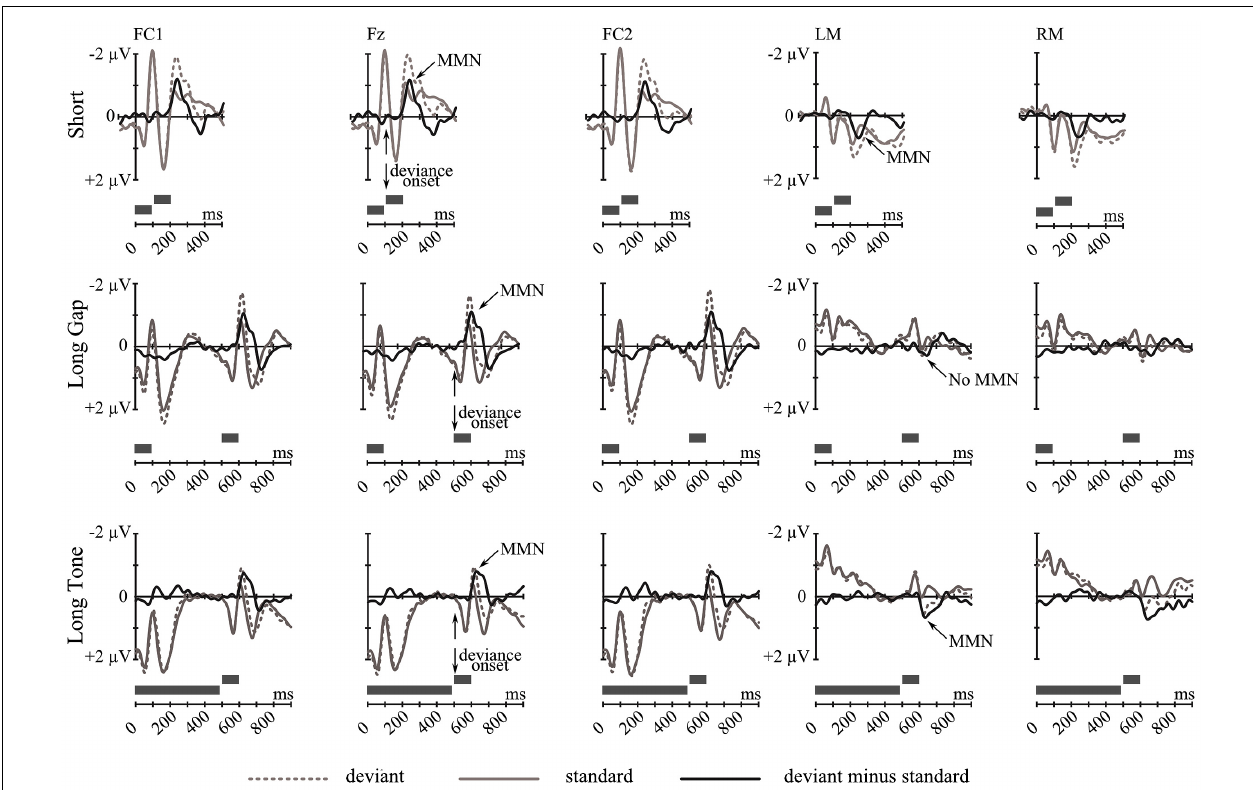
difference wave (black) is depicted. Gray bars at the bottom of each diagram indicate an exemplary deviant tone pair. Vertical arrows point to the deviance onset. The elicitation of MMN is indicated. In each condition deviance onset is preceded by a 200-ms baseline interval (not highlighted).